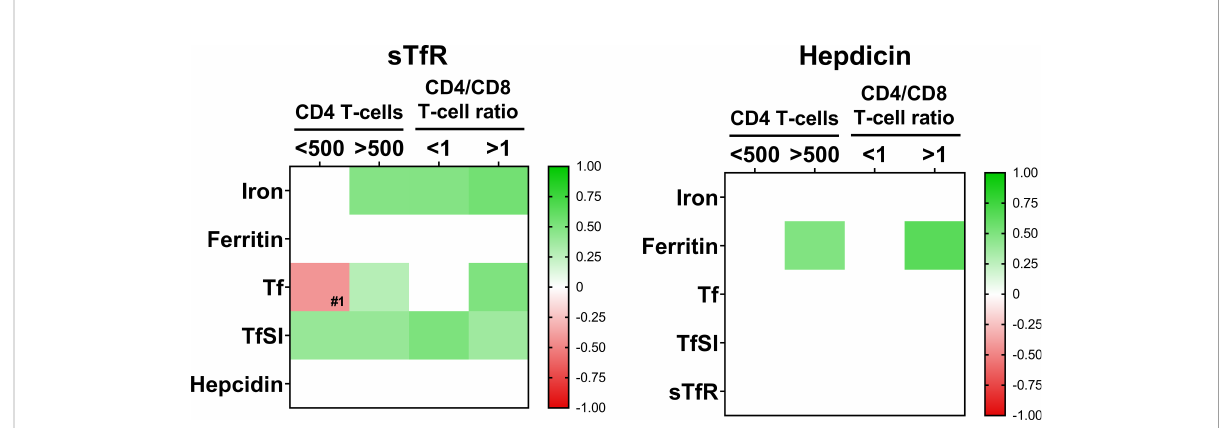
FIGURE 3 Interrelations among iron-metabolism parameters when patients are classi fi ed according to CD4 T-cell counts (below 500 cell/mm 3 , N=24 and over 500 cell/mm 3 , N=68) or CD4/CD8 T-cell ratio (ratio <1, N=55 and ratio >1; N=37). Color intensity of boxes represents Spearman ’ s rank correlation coef fi cient value as indicated in the color legend. All colored boxes represent statistically signi fi cant correlations, excepting for that noted as #1, p =0.072. White boxes represent correlations with p -values >0.1. Tf, transferrin; TfSI, transferrin saturation index; sTfR, soluble transferrin receptor.